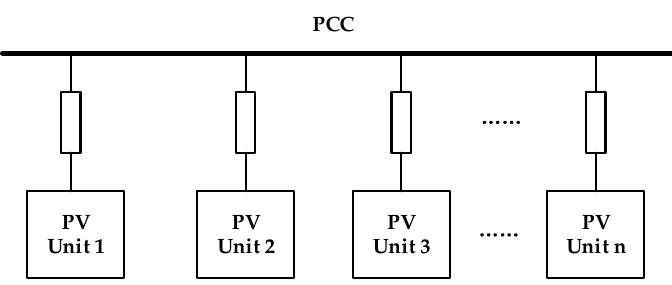
Figure 6. Radial topology of PV power plant.